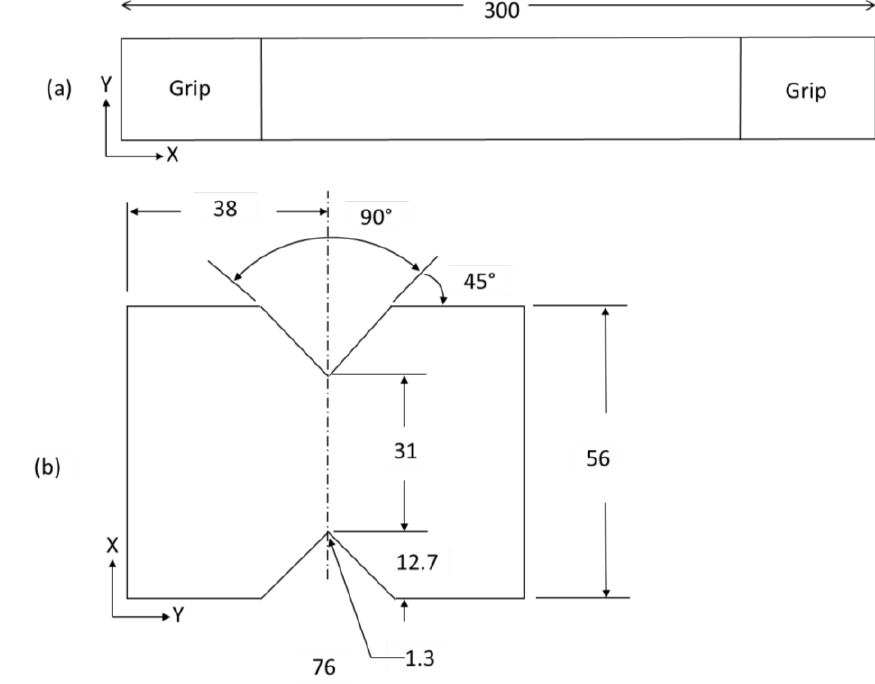
Figure 3. Specimen geometry (dimension in mm): ( a ) tensile specimen and ( b ) shear specimen.